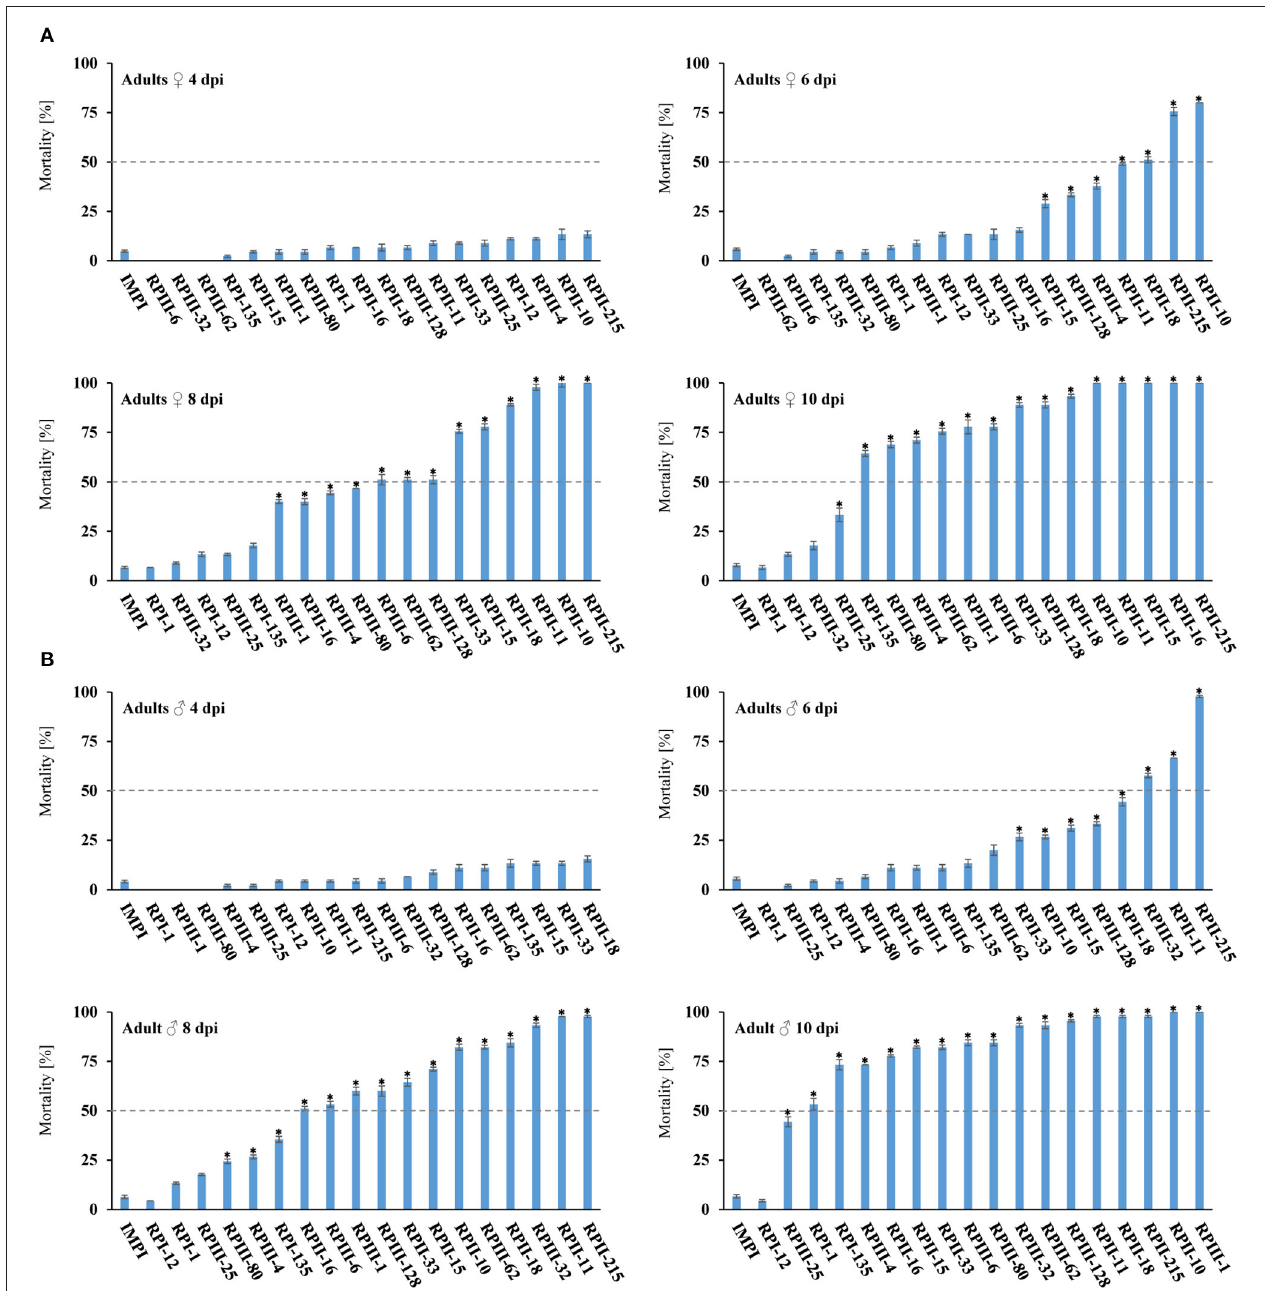
FIGURE 3 | Mortality rates of T. castaneum adults after knockdown. Injection of 150 nl of dsRNA [250 ng/ µ l] targeting different RNA polymerase subunits into T. castaneum (A) female and (B) male adults. Mortality rates were tracked every 48h for 10 days. The G. mellonella gene IMPI was used as negative control. The data represent three biological replicates ( n = 15 for each replicate). Asterisks show statistical difference ( p < 0.001). The results were analyzed with analysis of variance (ANOVA) ( Supplementary Table 1 ).